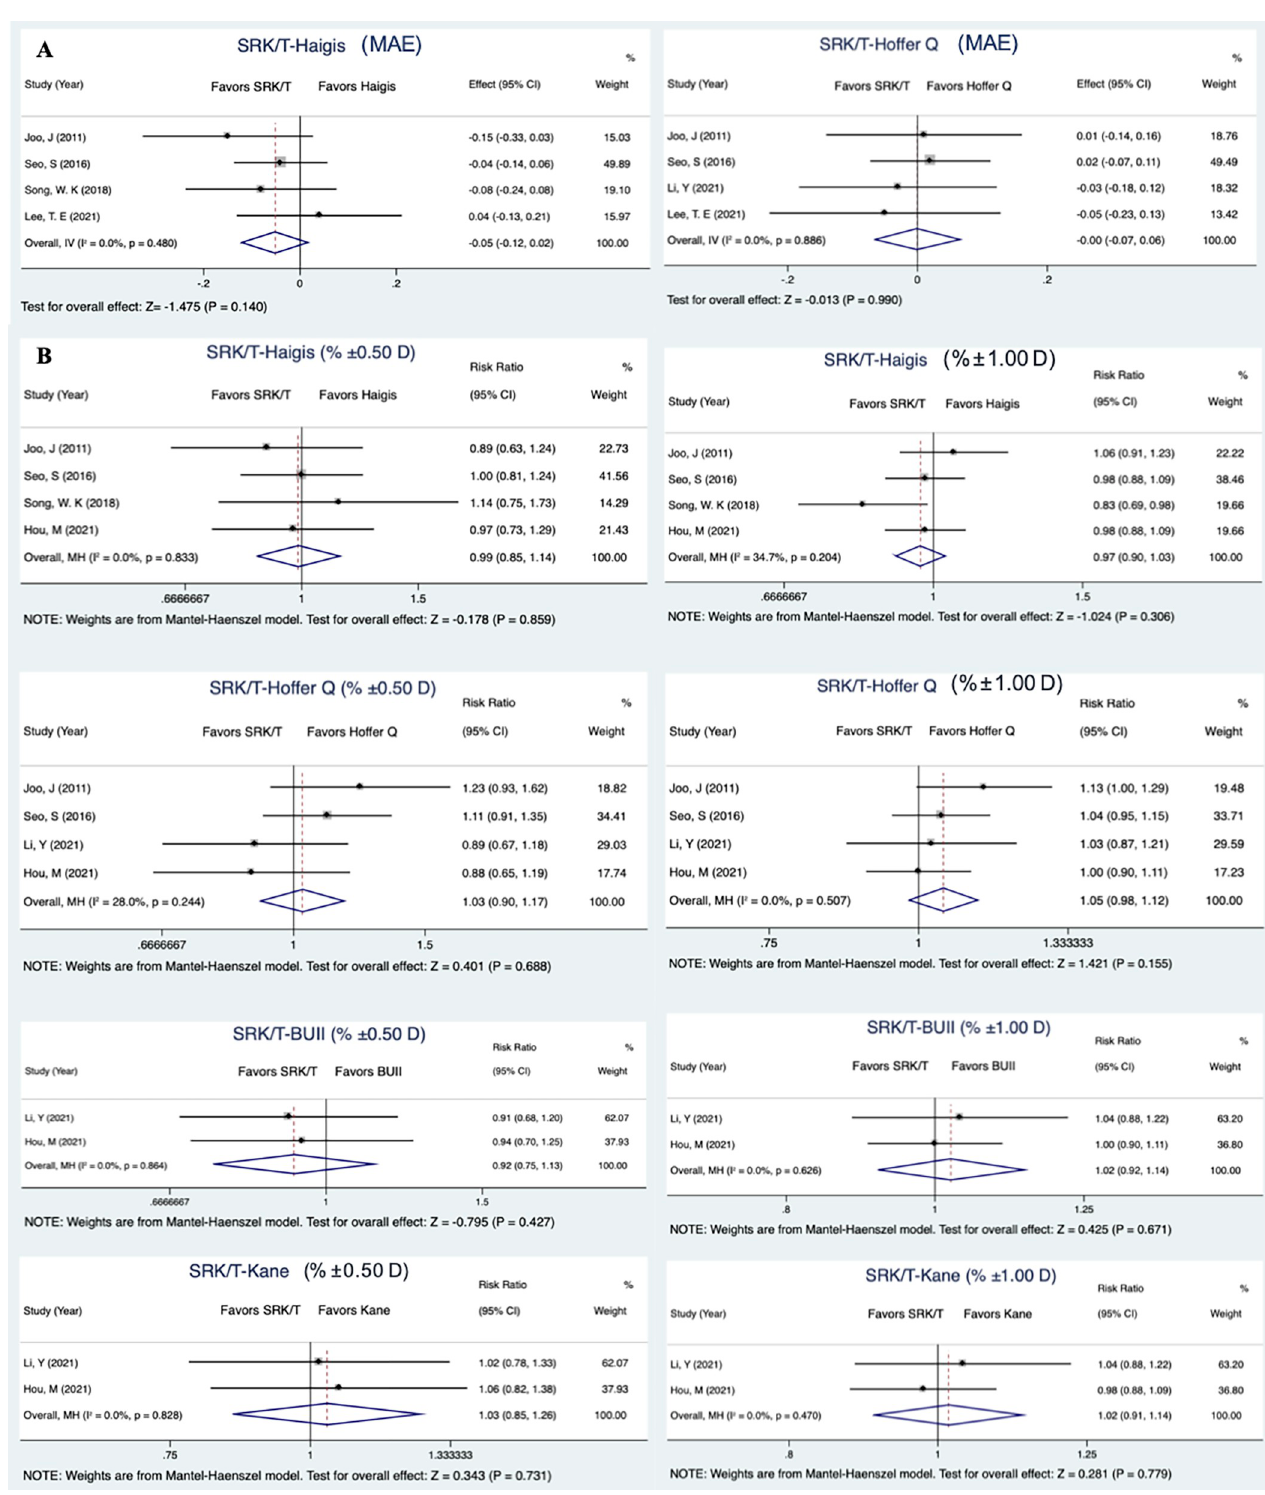
Fig 4. The forest plots of traditional meta-analysis for the analysis of MAE and % ± 0.50/1.00 D. Direct comparisons of MAE between SRK/T and Haigis/ Hoffer Q (A) and % ± 0.50/1.00 D between SRK/T and Haigis/Hoffer Q/BUII/Kane (B) were displayed in the forest plots. P value of Cochran’s Q test (for MAE) or Mantel-Haenszel Q test (for % ± 0.50/1.00 D) were reported for testing study heterogeneity. SRK/T: Sanders, Retzlaff, Kraff/theoretical; BUII: Barrett Universal II.